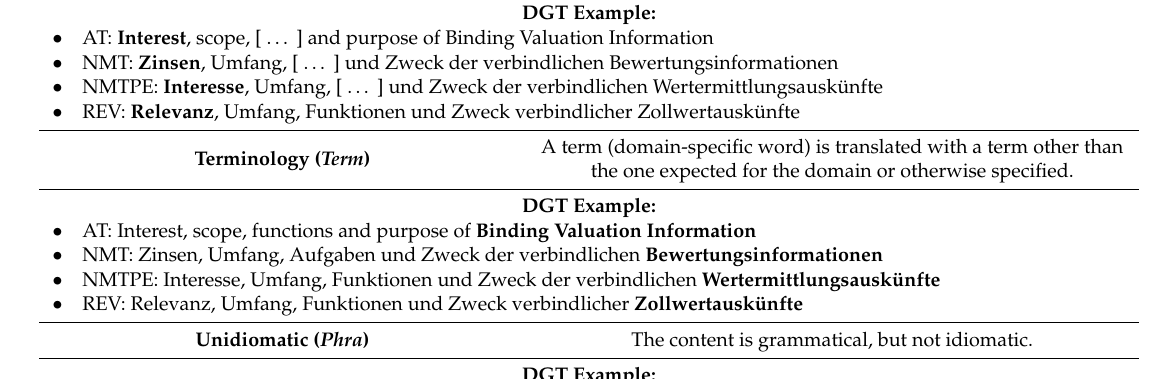
Table 1. MQM issues, their definitions and Directorate-General for Translation (DGT) examples of manual error annotation. MQM Issue MQM Definition Mistranslation ( Mistr ) The target content does not accurately represent the source